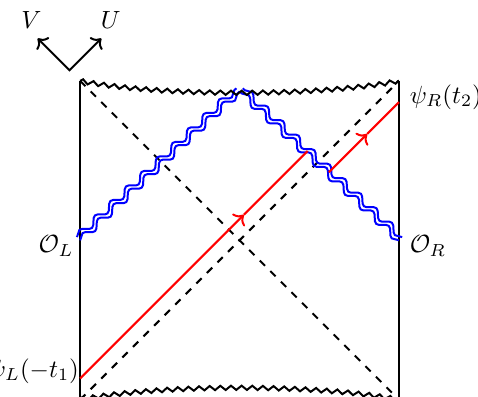
Figure 4. The non-local coupling between O L and O R introduces a negative-energy shock wave in the bulk that makes the wormhole traversable. The traversability can be diagnosed by a two-sided correlation function (3.20) involving ψ L and ψ R